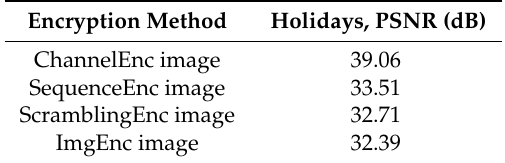
Table 4. Comparison of PSNR on Holidays by different encryption